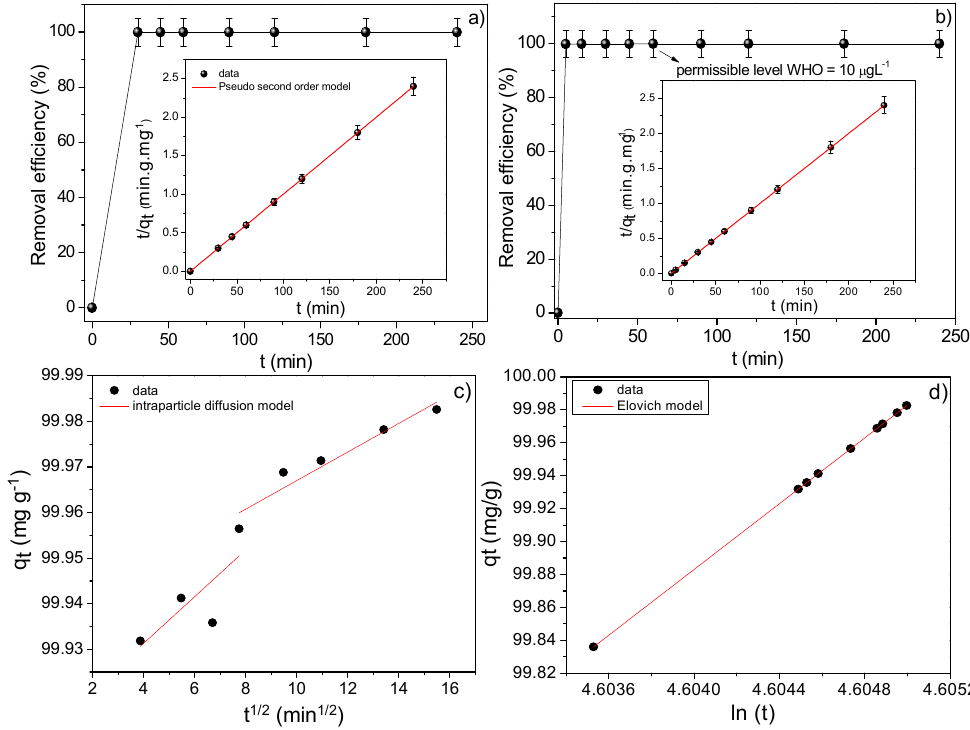
Figure 9. Time dependence of Pb(II) adsorption capacity for the zeolite type 5A ( a ) and NPZEO3 ( b ). The insets show the data fitted to the pseudo kinetic order model. Intraparticle diffusion model ( c ) and Elovich kinetic model ( d ) applied to the NPZEO3 sample are also displayed. WHO, World Health Organization. Table 3. Adsorption kinetic parameters of several systems found in the literature given for comparison, where t is the equilibrium time for adsorption. NPs, nanoparticles.